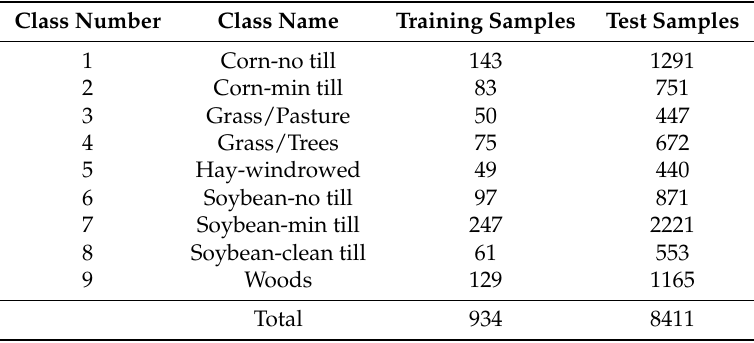
Table 1. Indian Pines HSI: Number of training and test samples.